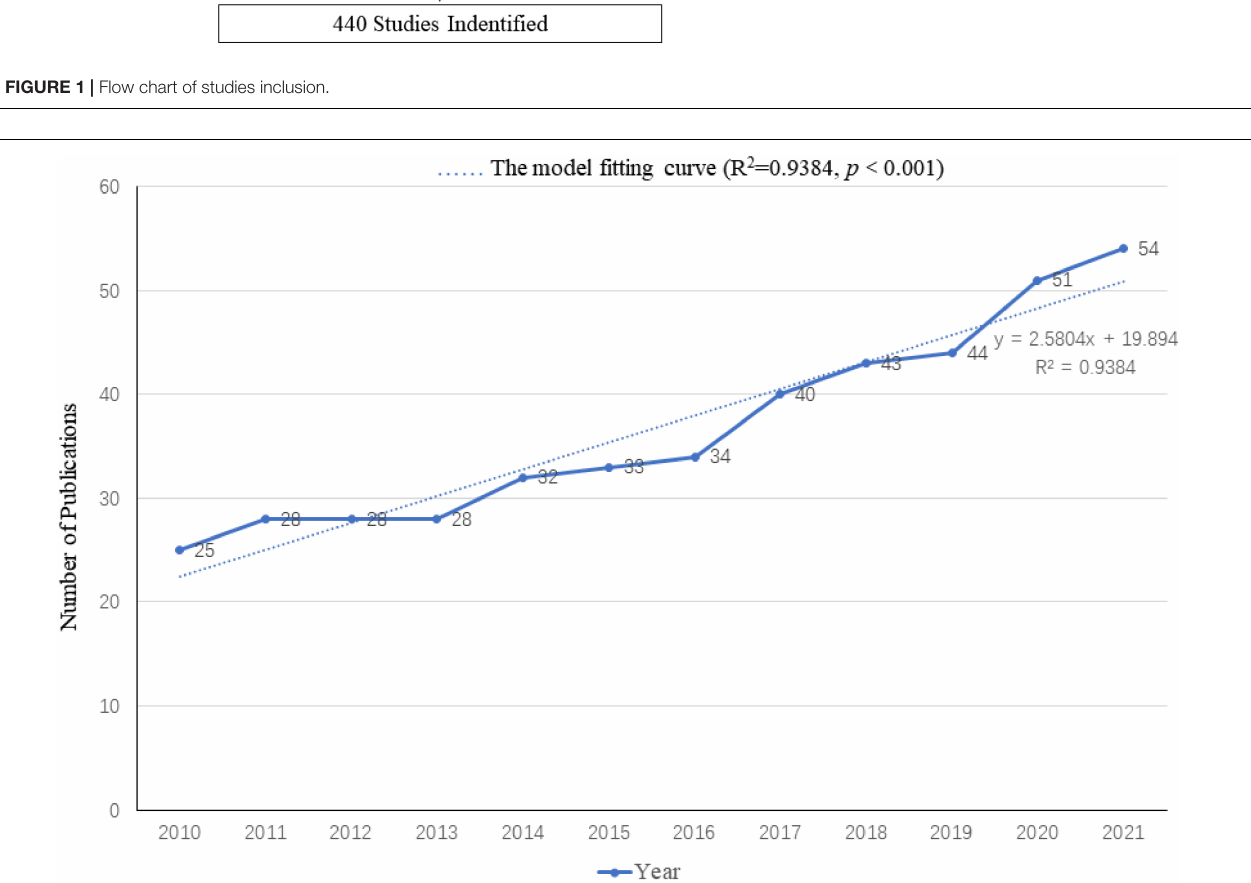
FIGURE 2 | Annual publication outputs and the model fitting curve of the time trend of transcranial magnetic stimulation (TMS) in pain research.